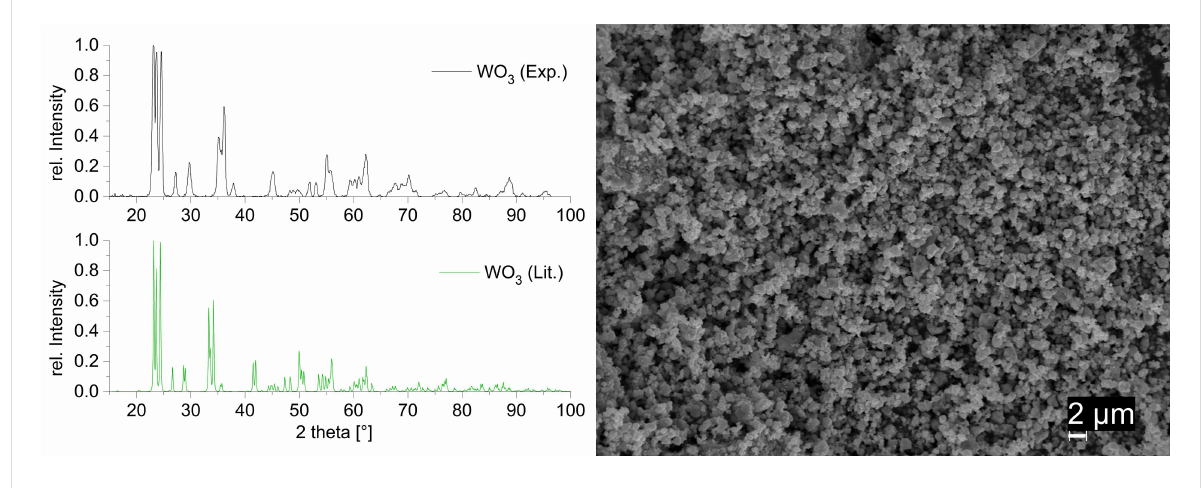
Figure 3: Left: P-XRD pattern of WO 3 powder calcined at 600 °C for 2 h. (space group of WO 3 : P 2 1 / n ). Right: SEM images of WO 3 powder calcined at 600 °C for 2 h.